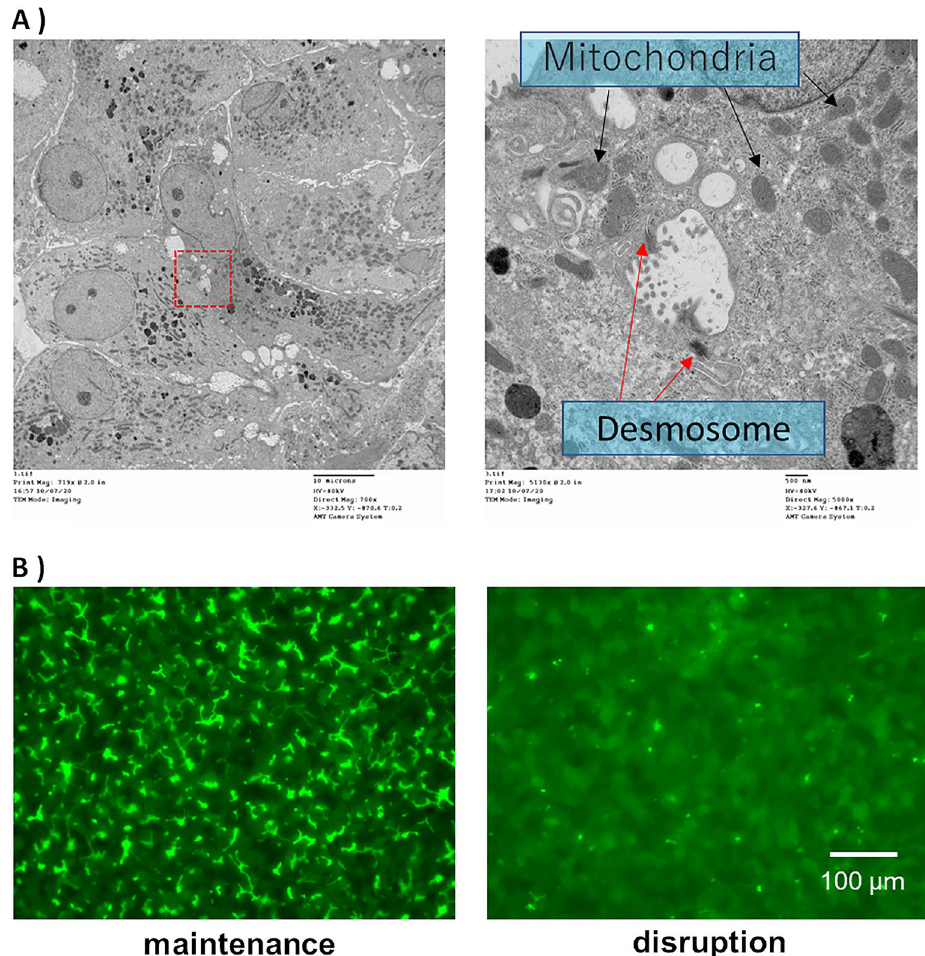
Figure 7. ( A ) Microstructure of bile canaliculi was observed using transmission electron microscopy. There are bile canaliculi in the dotted line in the left electron microscopy image. The right electron microscopy image is an enlarged view of the dotted line in the left that shows the microstructure of bile canaliculi. hiPSC-Heps were cultured in the LTM medium for 28 days and then sandwich-cultured in a maintenance medium for 9 days. ( B ) Accumulation of model fluorescein substrates into bile canaliculi under maintenance or disruption conditions and the microstructure of bile canaliculi. Human-induced pluripotent stem cell-derived hepatocytes (hiPSC-Heps) were cultured in a long-term maintenance (LTM) medium for 28 days and then, they were sandwich-cultured in a maintenance medium for 9 days. Fluorescence images reveal the presence of 5-(and- 6)-carboxy-2 ′ ,7 ′ -dichloro-fluorescein (CDF), which accumulated into bile canaliculi under maintenance or disruption conditions. hiPSC-Heps were cultured in the LTM medium for 28 days and then sandwich-cultured in a maintenance medium for 9